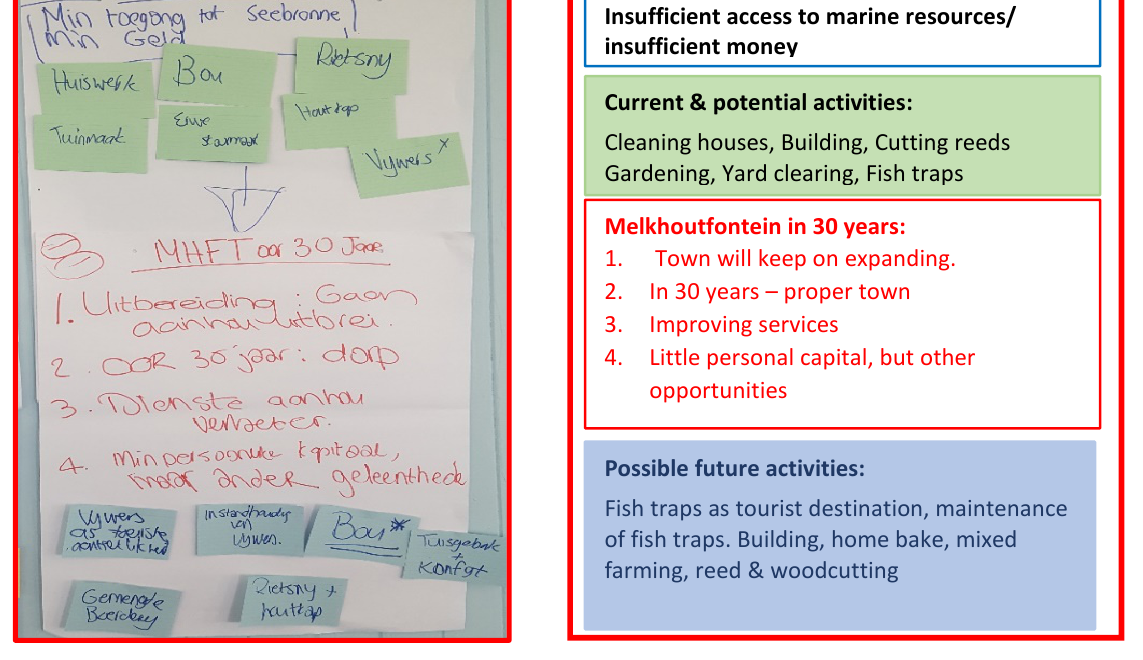
Figure A1.1. Elements of the “Insufficient access to marine resources/Low disposable income scenario” as identified in workshop 3: green cards depict current and potential activities that participants engage in at present. The red text reflects the town in 30 years; blue cards indicate future livelihood activities that could be engaged in. The left panel shows a photograph of the results of the original story exercise in Afrikaans, whilst the right panel provides a translation.